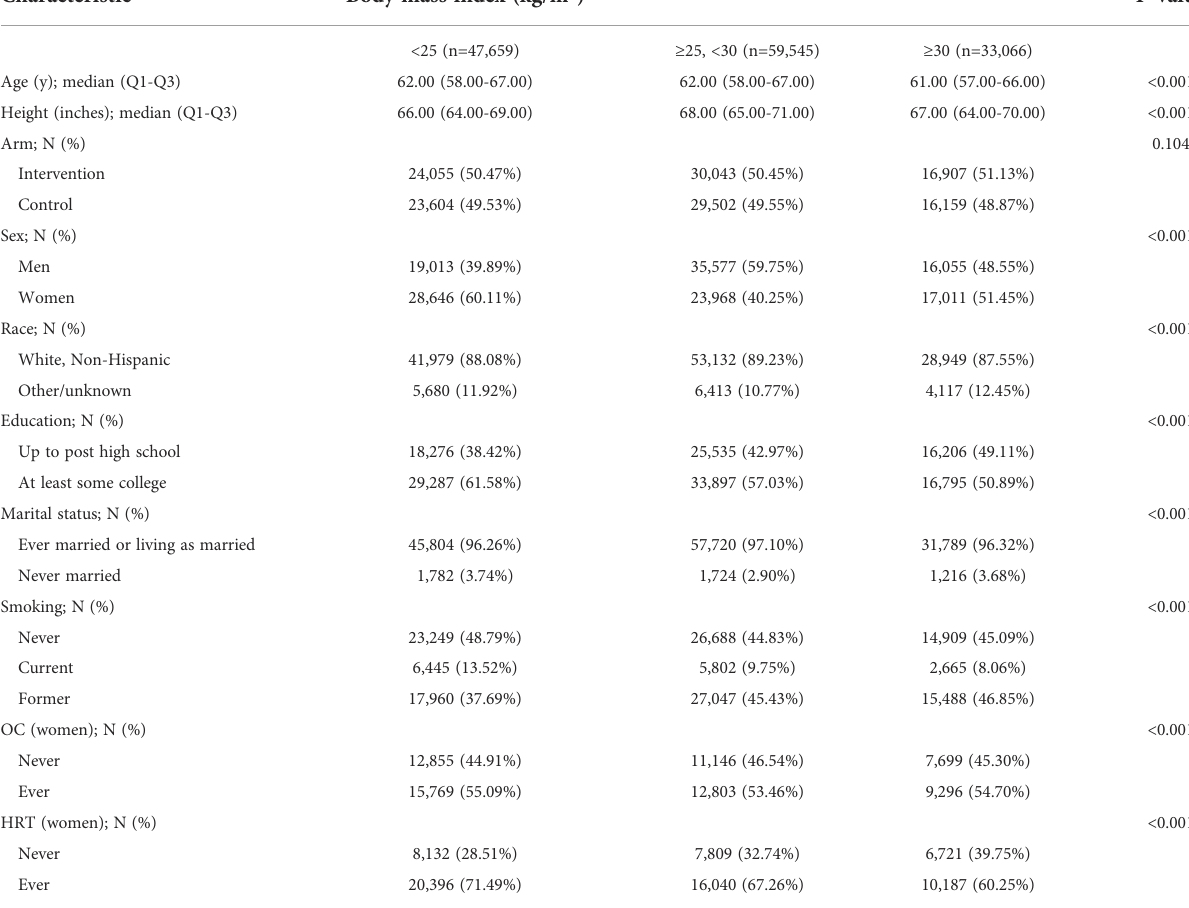
TABLE 1 Basic characteristic according to body mass index in the PLCO